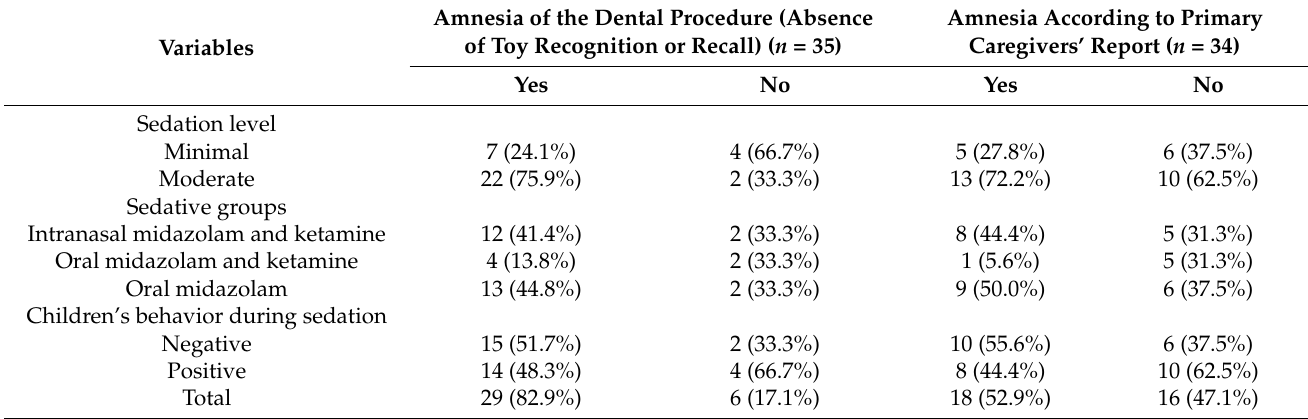
Table 1. Frequencies of amnesia during pediatric procedural sedation according to different perspectives and variables.